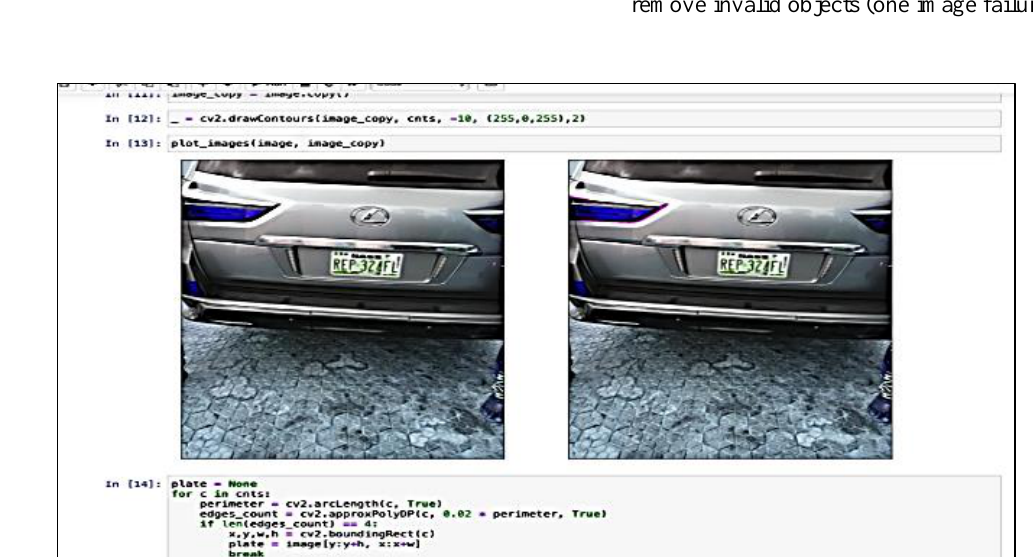
Figure 10: Image of